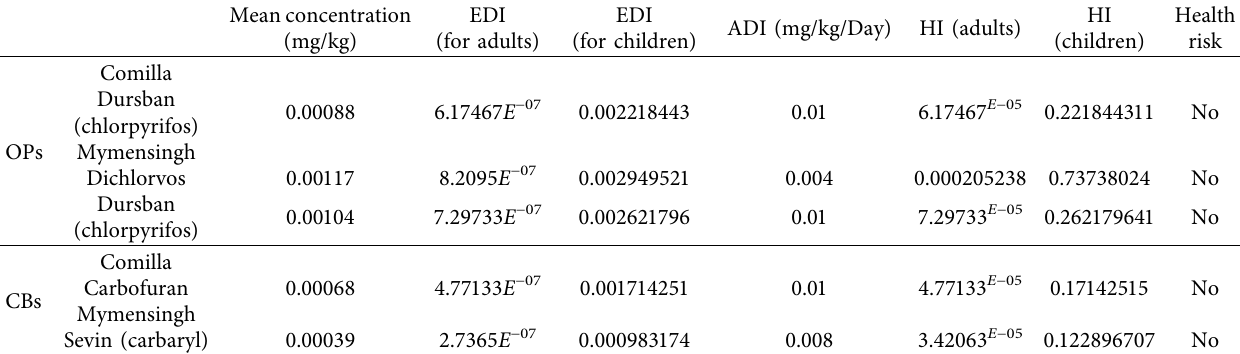
Table 7: EDI, ADI, and HI values of OPs and CBs in adults and